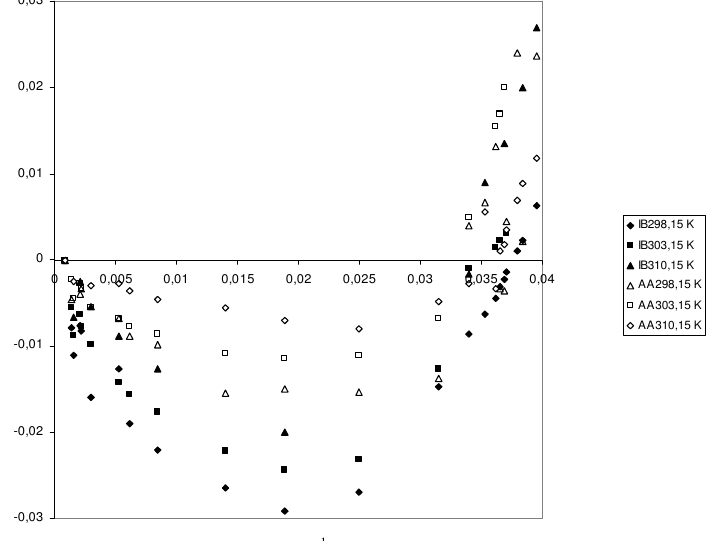
L vs. Na-AA and Na-IB concentrations at various Figure 6. Dependences of 1